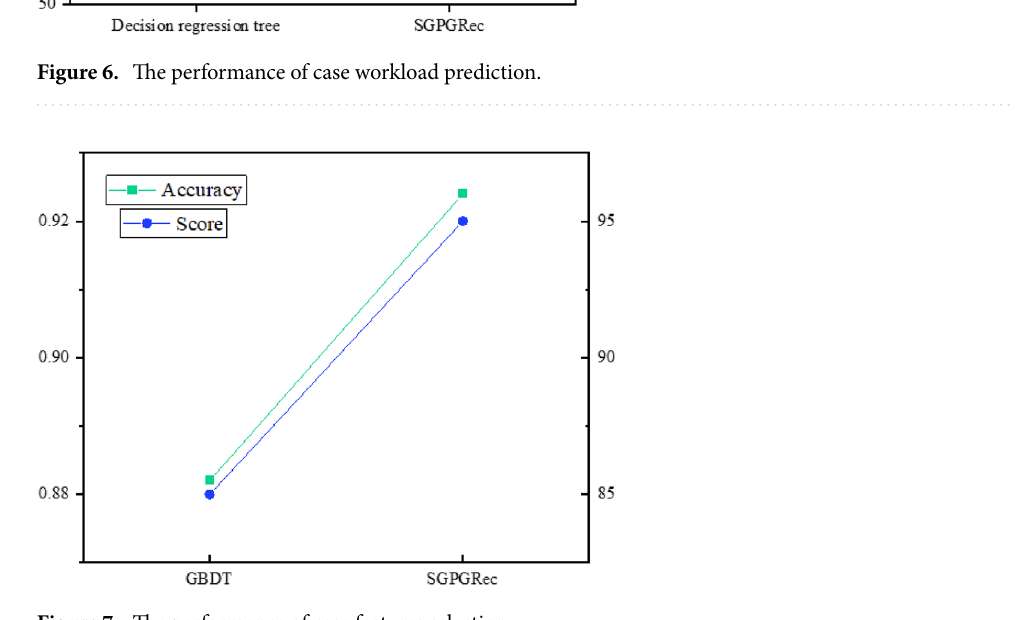
Figure 7. The performance of case features